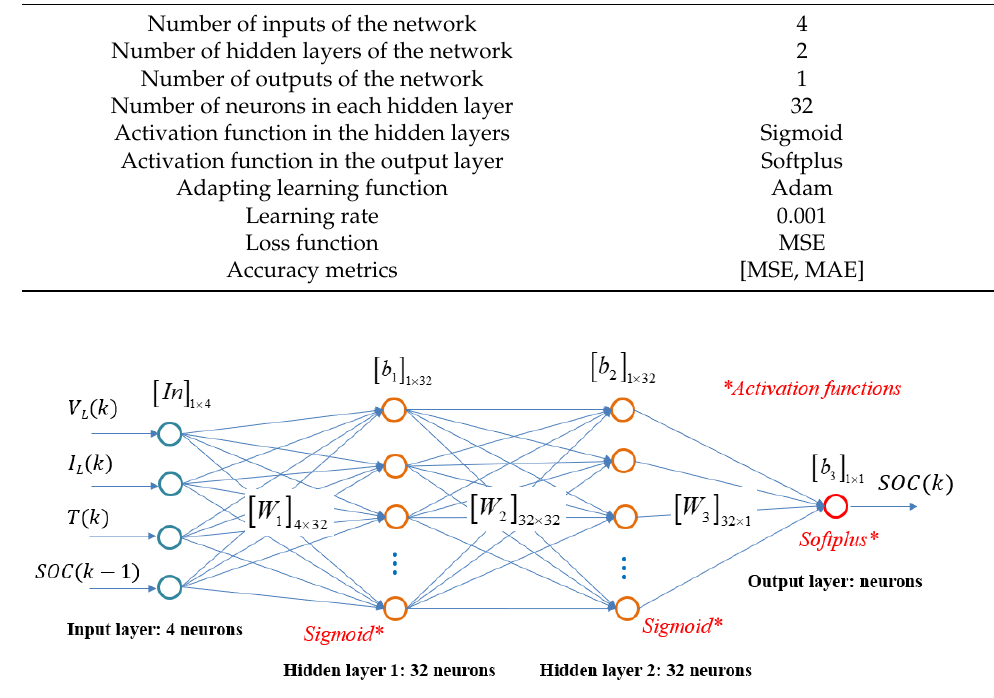
Figure 12. Detailed configuration and parameters of the designed ANN.